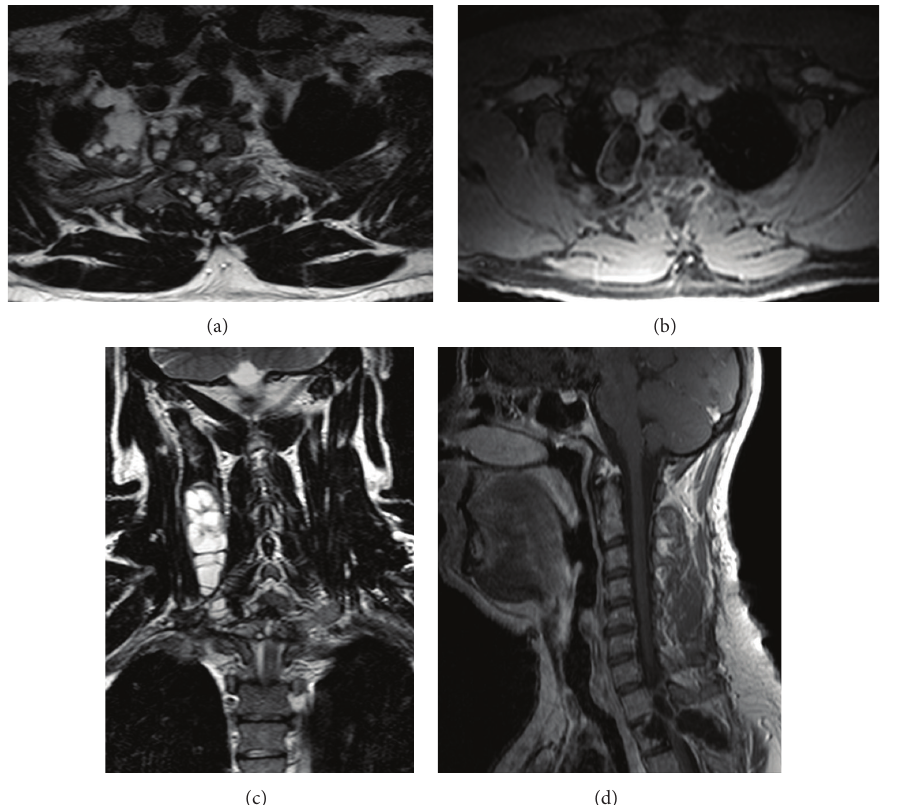
Figure 2: T2 images (a) and (b) show a cystic inhomogeneous tissue localized in the chest and the paravertebral muscles on the right that erodes second rib and D1 and D2 vertebrae compressing the spinal cord at that level. T1 after gadolinium intravenous injection images (c) and (d) demonstrates a predominantly cystic component that presents peripheral enhancement after contrast medium.